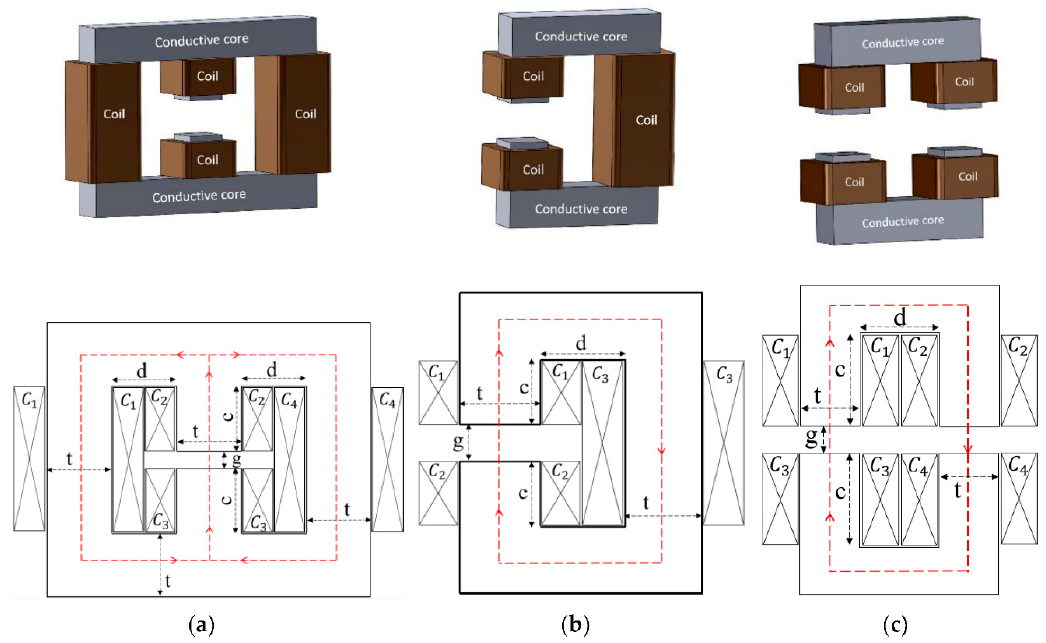
Figure 8. Three electromagnet designs considered for the proposed adaptive tuned vibration absorber (ATVA). ( a ) H-shaped electromagnet; ( b ) C-shaped electromagnet; and ( c ) U-shaped electromagnet. Reprinted from [25], © 2020 with permission from MDPI.